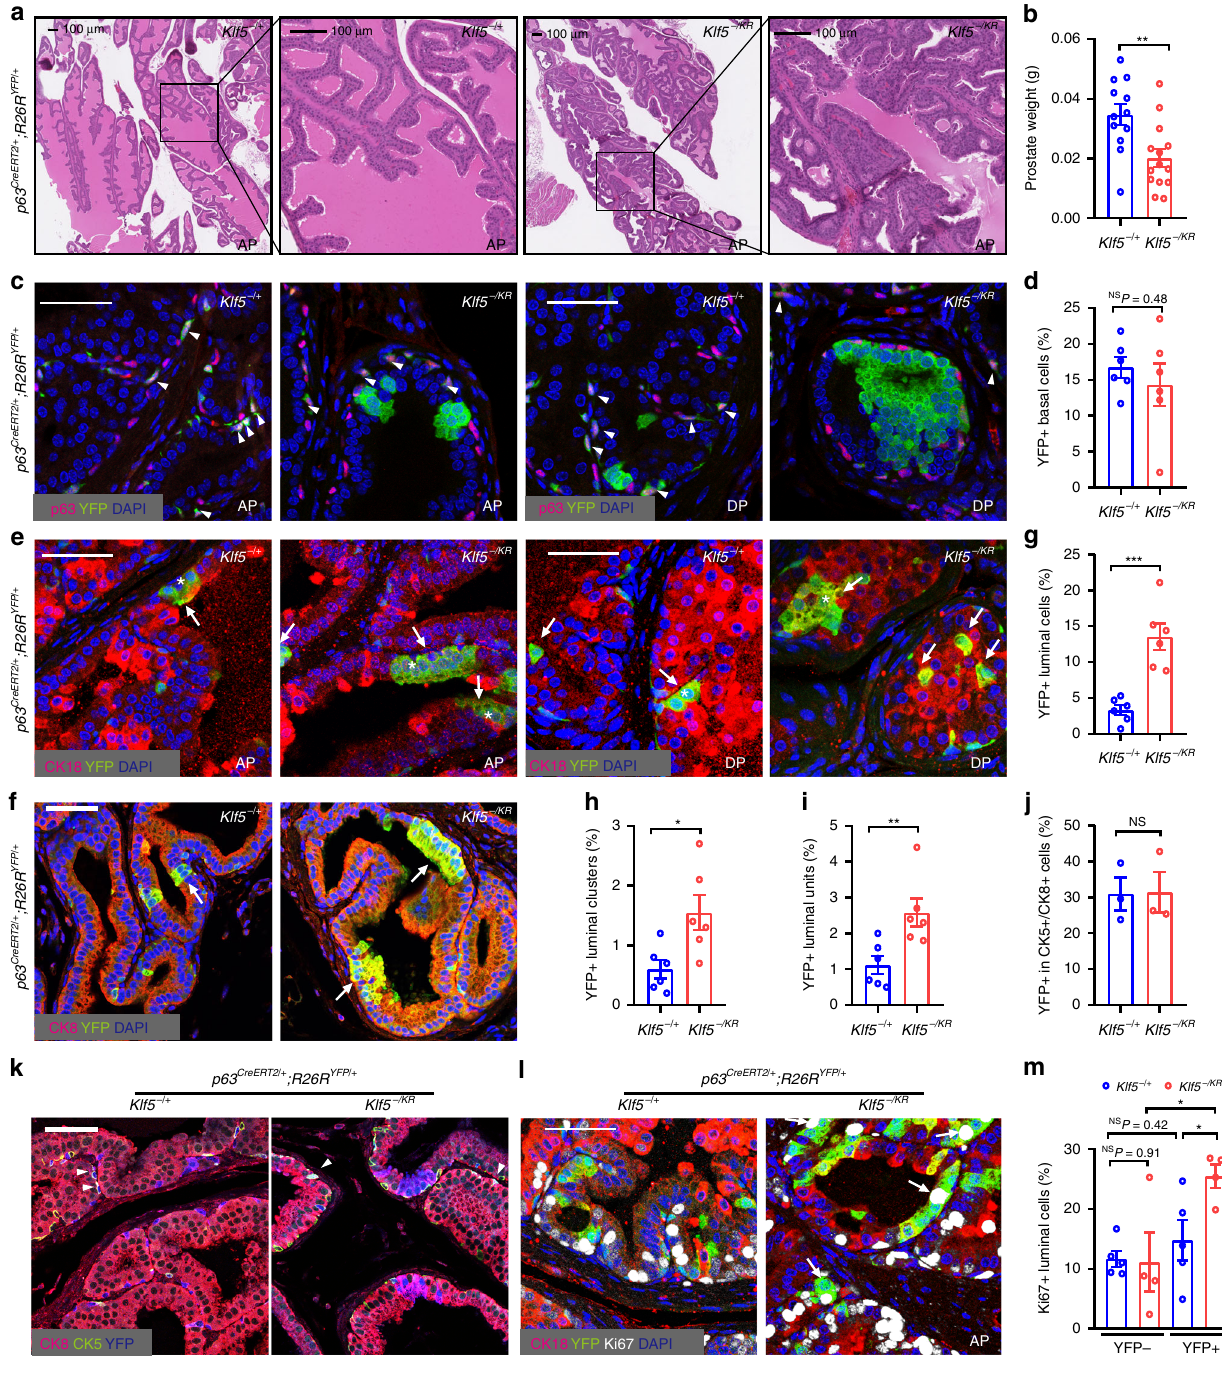
castration-regeneration cycle (Supplementary Fig. 8b – d), and the luminal cell proliferation index did not increase (Fig. 8d). In prostates of similar ages without undergoing a castration- regeneration cycle, Klf5 KR knockin still increased YFP + luminal cells, YFP + luminal clusters, and YFP + luminal units, while YFP + basal cells were not affected (Fig. 8e – g and Supplementary Fig. 8e, f), consistent with the results from 8-week-old mice. Klf5 KR knockin also increased the ratio of YFP-labeled luminal units to basal cells, although the increase did not reach statistical signi fi cance (Supplementary Fig. 8g). Therefore, while increasing the number of luminal cells before castration, interruption of Klf5 acetylation in basal